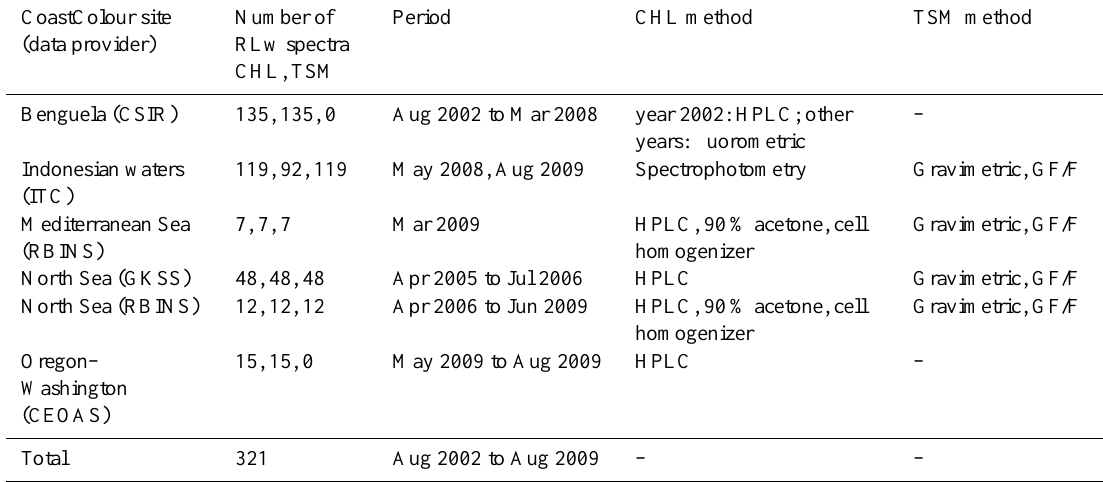
Table 9. The number and period(s) of measurement of in situ RLw and TSM and/or CHL concentrations, collected at each CoastColour site within the in situ reflectance data set. The methods for CHL and TSM measurements are also provided.